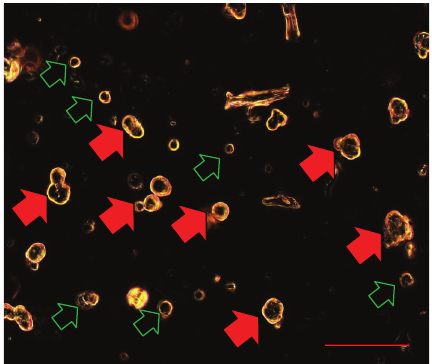
Figure 13: Sphere formation assay on OSA3-CSCs at 14 days. After 14 days from the start of the assay, several small spherical colonies surrounded by single cells (single cells are indicated by the black/green arrows) can be observed. The sarcospheres (some of these are indicated by the black/red arrows) appear floating in the medium observation in phase contrast. Original magnification: 20x. Bar size: 100 𝜇